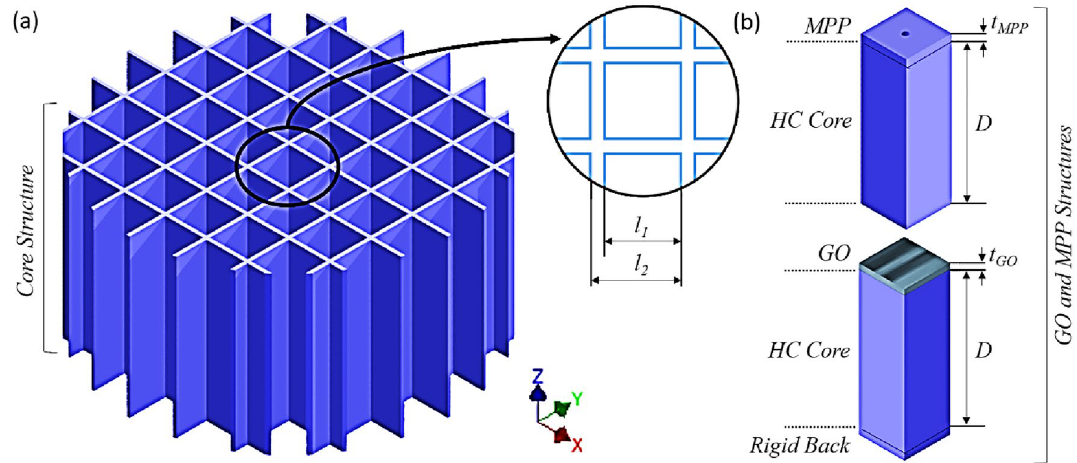
Figure 1. ( a ) Schematic of honeycomb (HC) structure which is either composed of a micro-perforated panel (MPP) as a top facesheet or a graphite oxide (GO) layer, ( b ) unit cell of MPP-HC and GO-HC. Sound absorption of the metamaterial is investigated from a plane acoustic wave normally incident to the top